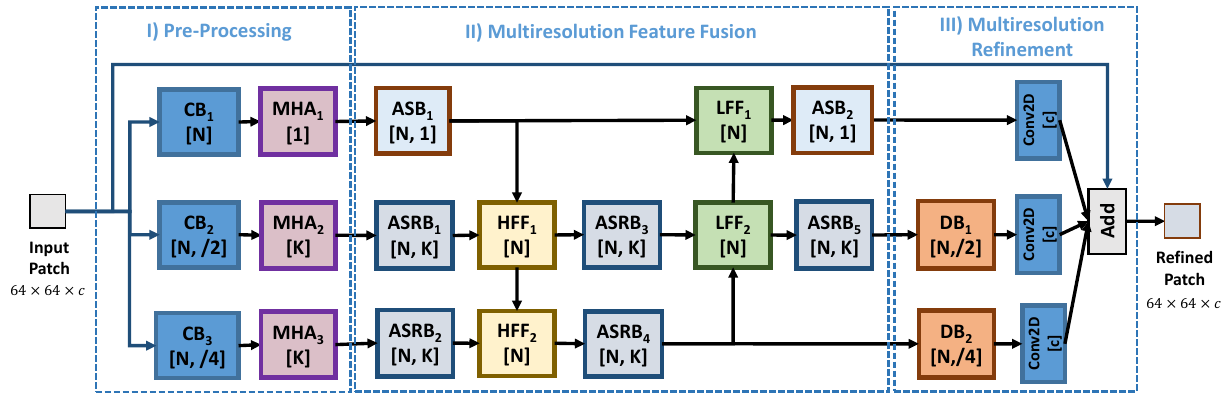
Figure 2. Proposed attention-based shared weights quality enhancement convolutional neural network, which is built using the following blocks: convolutional Block (CB), deconvolutional block (DB), attention-based shared weights block (ASB), attention-based shared weights residual block (ASRB), multi-head attention block (MHA), low-resolution feature fusion (LFF), and high-resolution feature fusion (HFF). The layer structure of each building block is presented in Figure